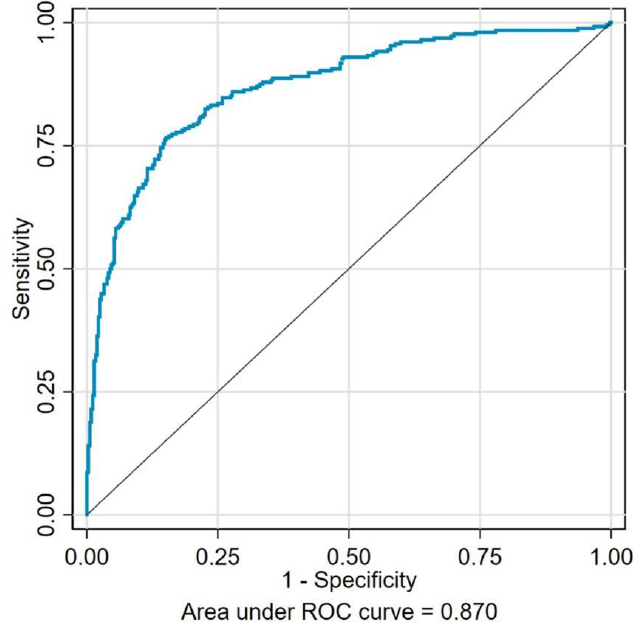
Figure 1. The receiver operating characteristics for seven risk factors (low education levels, physical inactivity, stroke, low serum albumin levels, CKD Stages 3–4, macroalbuminuria, and a poor QOL) combined to predict depression in DKD patients. The area under the curve was 0.870.